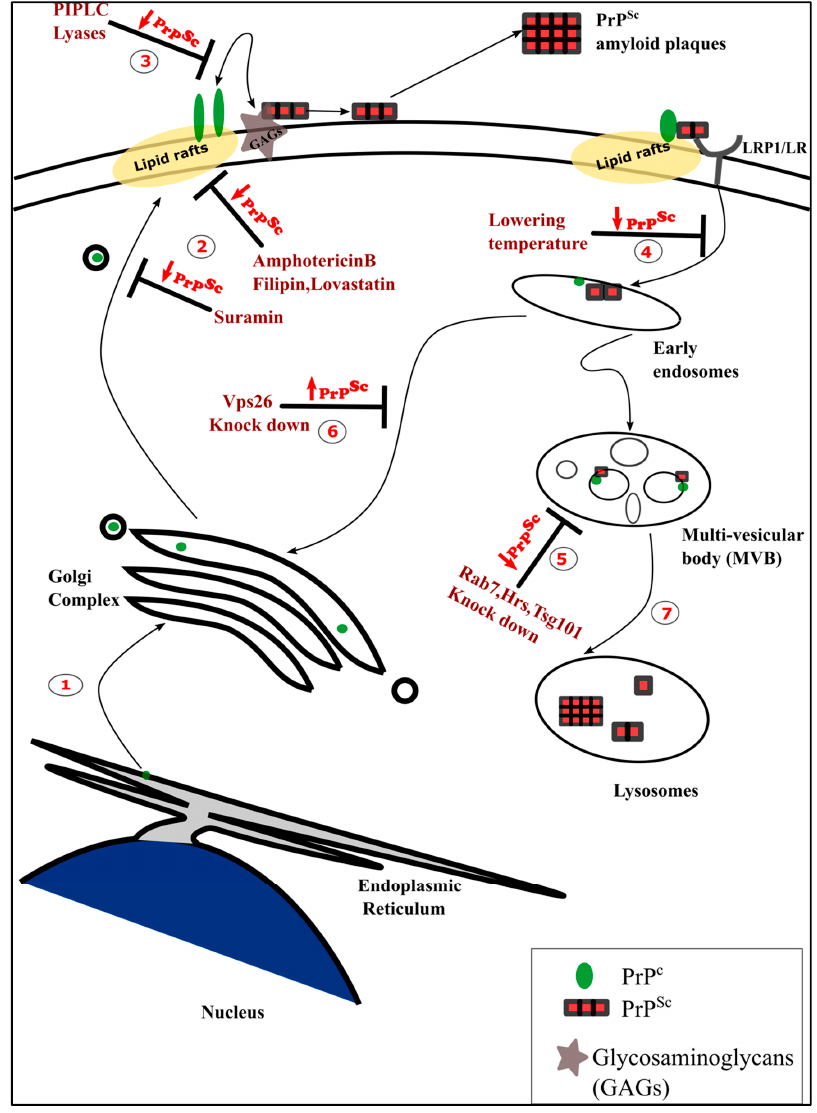
Figure 1. Trafficking of a cellular form of the prion protein (PrP c ) and an infectious and aggregation prone isoform (PrP Sc ) and the potential inhibitors of the pathogenic conversion at the different stages of trafficking. ( 1 ) Cellular PrP c is synthesized in the endoplamic reticulum (ER), transported to the Golgi complex, and then is finally localized at the plasma membrane in the lipid rafts. ( 2 ) Preventing the surface localization or the accessibility of PrP c at the plasma membrane (PM) is one strategy adopted to reduce PrP Sc levels. This can be done by treating cells with suramin, which retains the PrP c in the Golgi or by abrogating the proper lipid raft formation by treating with amphotericin B, filipin, or lovastatin, which prevent the localization of PrP c in the lipid rafts and subsequently prevent PrP Sc formation. ( 3 ). Phosphoinositide phospholipase C (PIPLC)-mediated cleavage of PrP c or the removal of glycosaminoglycans (GAGs) by lyases, reduce PrP Sc levels. ( 4 ). Preventing the endocytosis of PrP c / PrP Sc by lowering the temperature and ( 5 ) preventing the maturation of the multi-vesicular bodies can also reduce PrP Sc propagation. ( 6 ) In contrast, inhibiting the retrograde tra ffi cking to Golgi increases PrP Sc levels. ( 7 ) Eventually, PrP Sc accumulates in lysosomes where it is partially